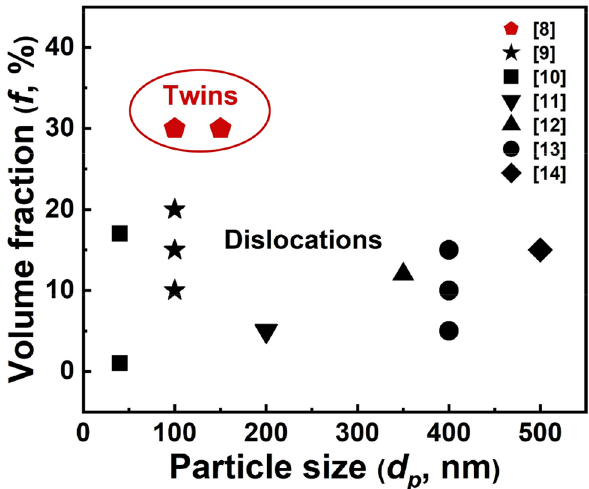
Figure 1. The variation of thermal mismatch defect type with the SiC volume fraction and size. For SiC/ Al composites with low volume fraction and larger size of particles, the defect type in the thermal mismatch affected region is usually dislocations. On the contrary, thermal mismatch twins appear near the SiC/Al interfaces with high volume fraction and smaller size of particles.